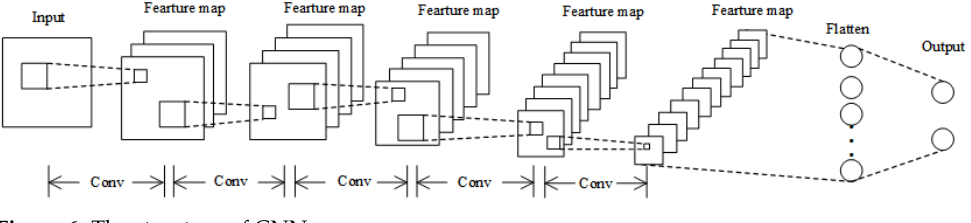
Figure 6. The structure of